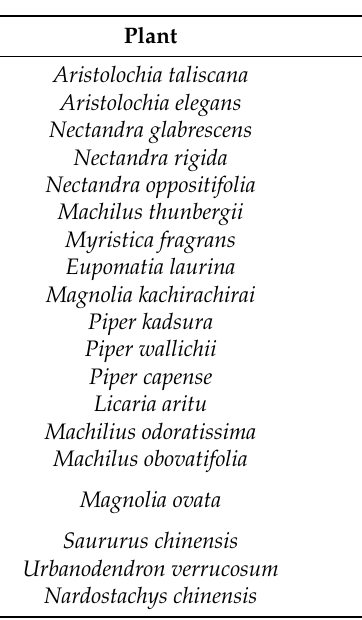
Table 1. Natural sources of